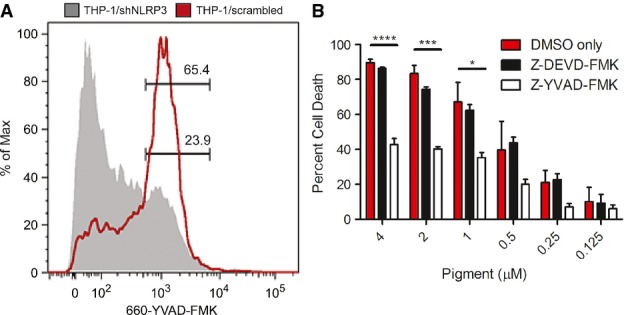
The GBS hemolytic pigment/lipid toxin induces caspase 1 activation and pyroptosis
THP-1 macrophages were treated with GBS pigment, and caspase 1 activation was measured by flow cytometry using a FLICA reagent. Pigment treatment of the scrambled shRNA control cell line induces more caspase 1 activation compared to the shNLRP3 cell line, demonstrating that the pigment activates caspase 1 exclusively through the NLRP3 inflammasome. Results are representative of three independent experiments.

WT THP-1 macrophages were treated with the caspase 1 inhibitor Z-YVAD-FMK, the caspase 3/7 inhibitor Z-DEVD-FMK, or DMSO only prior to treatment with the GBS pigment. YVAD is able to significantly decrease cytotoxicity in cells treated with GBS pigment, demonstrating that caspase 1 is required for GBS pigment-mediated cell death, characteristic of pyroptosis, while DEVD had no effect. Data are average of three independent experiments, error bars ± SEM. Significance was determined using Bonferroni's multiple comparison test following ANOVA (n = 3, ****P < 0.0001, ***P = 0.0002, *P = 0.014).